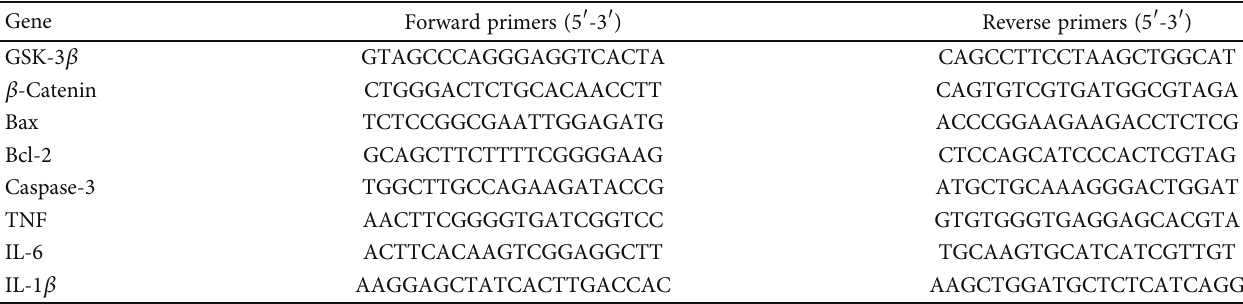
Table 1: Primer sequence for